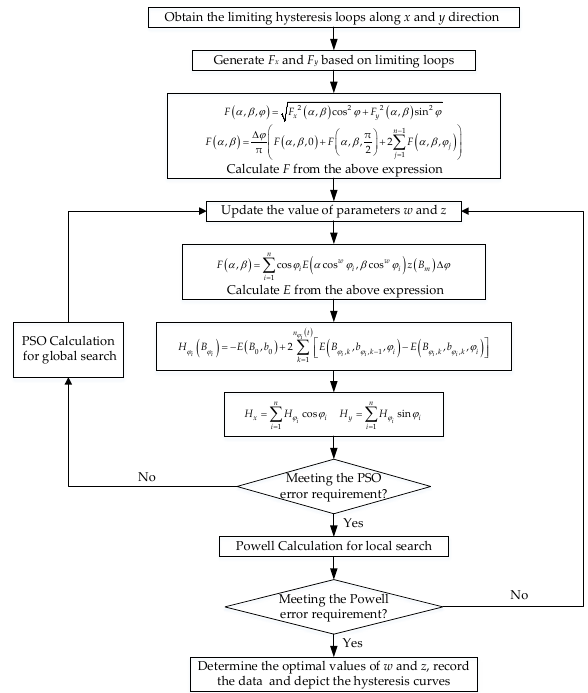
Figure 9. Flow diagram of simulation procedures.